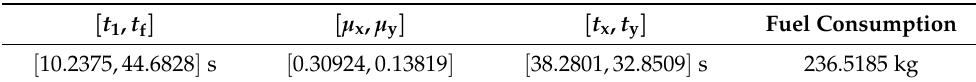
Table 2. Calculation results of Example